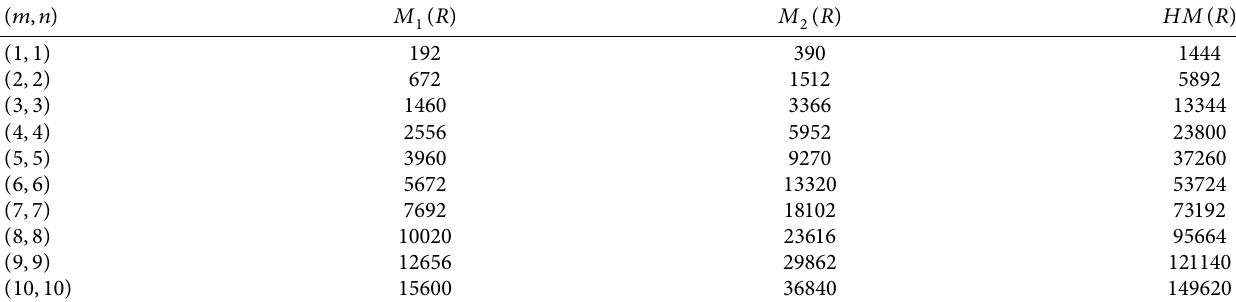
( G ) , M ( G ) , and HM ( G ) . 1 2